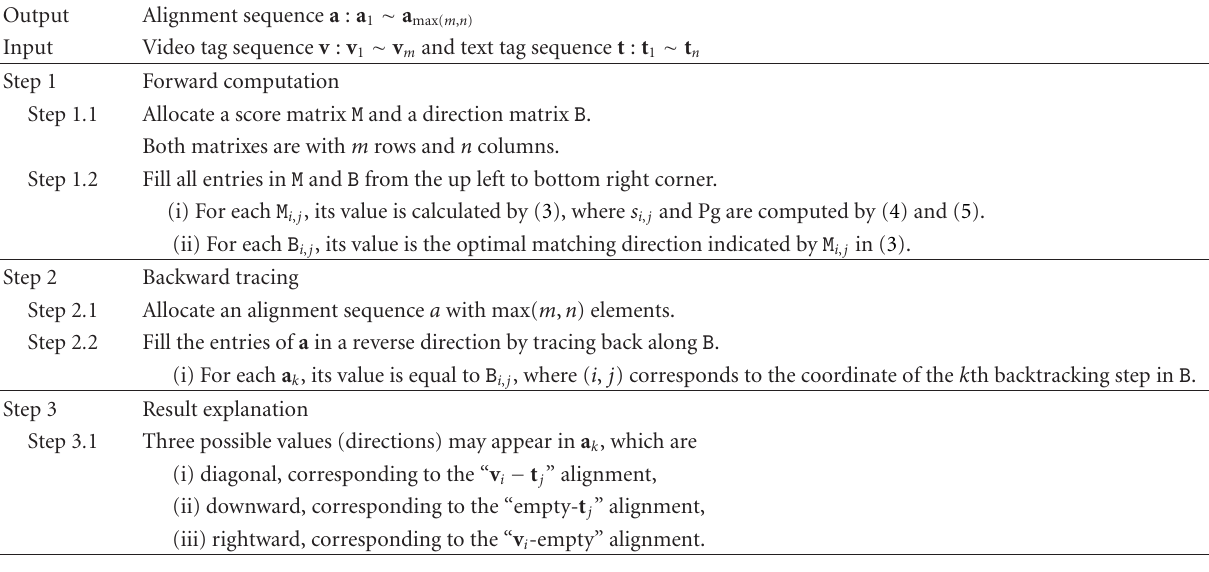
Table 3: Sequence matching algorithm for video-text alignment.